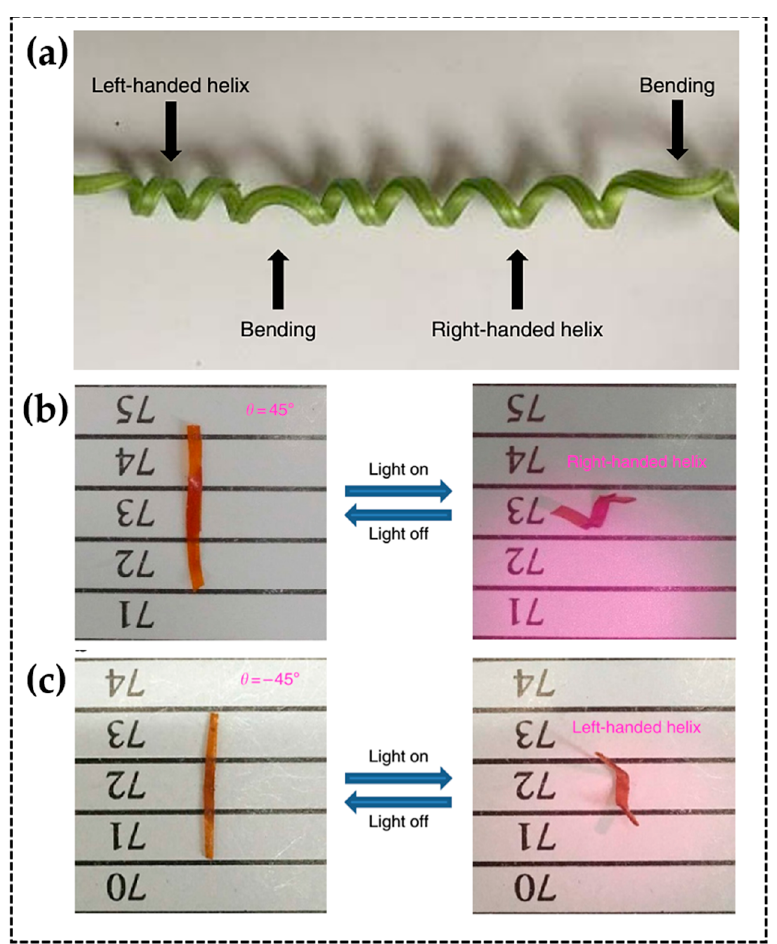
Figure 11. ( a ) The photograph of a cucumber plant tendril with bending and chiral twisting distortions ( b , c ). The bilayer LCE ribbon with 45 ° and − 45 ° , respectively, angle between the top and bottom layer was irradiated under an 808 nm near-infrared light for 8 s. Adapted with permission from Reference [80], Springer Nature, 2016.